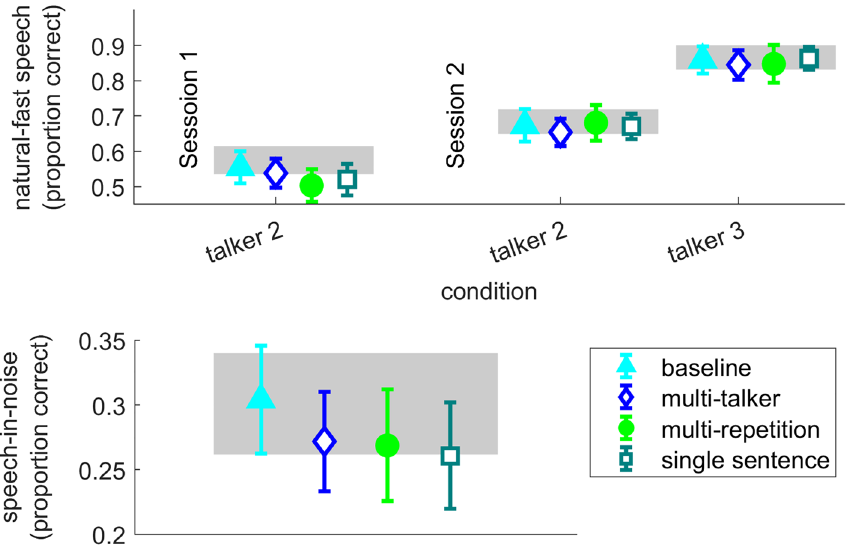
Figure 8. Natural-fast speech (top, left to right—Talker 2 in Session 1, Talker 2 in Session 2 and Talker 3 in Session 2) and speech-in-Noise (bottom) recognition (tested in Session 2 only). For each rapid-learning group mean (across all sentences per condition) and 95% confidence interval are shown. The gray rectangles mark the 95% confidence interval of the control group who participated in testing